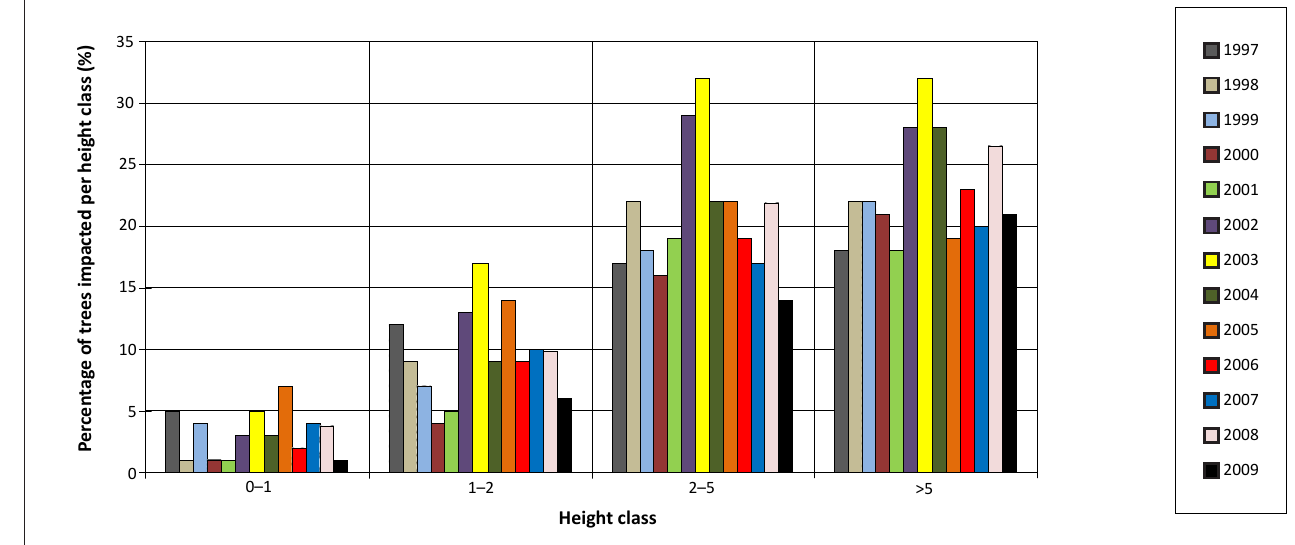
FIGURE 5: The proportion of trees of different height classes utilised by elephant.